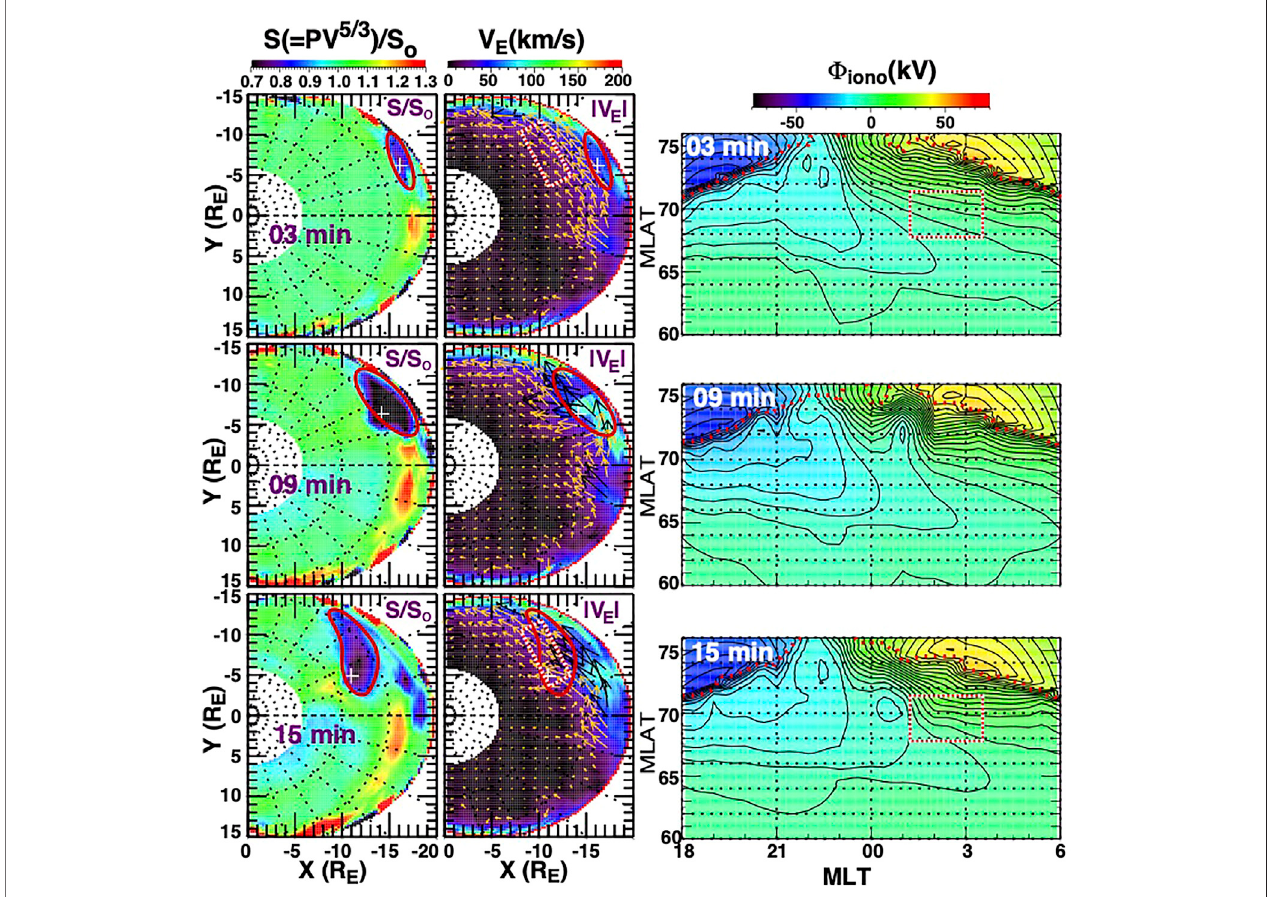
FIGURE 3 | UCLA-RCM results in the equatorial plane and ionosphere from Run three of Wang et al. (2018b). Format is the same as Figure 1 , and all model parameters were the same except the perturbation with centered at 01 MLT